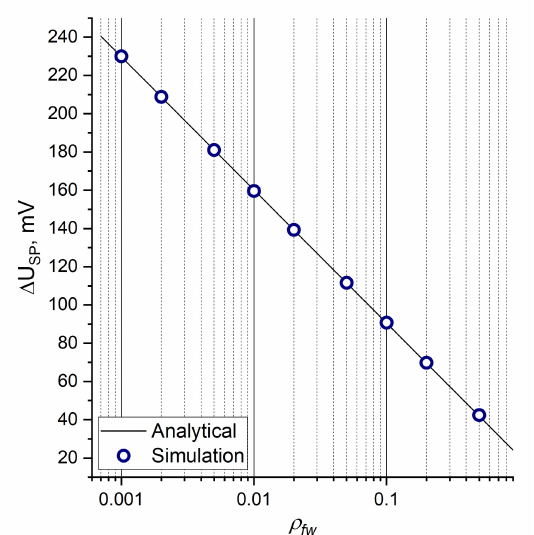
Figure 4. Dependence of SP anomaly amplitude on formation water resistivity, obtained using the developed algorithm (circles) at reservoir thickness h = 2.16 m ( h / r b = 20) and calculated (solid line) with the formula for static SP.